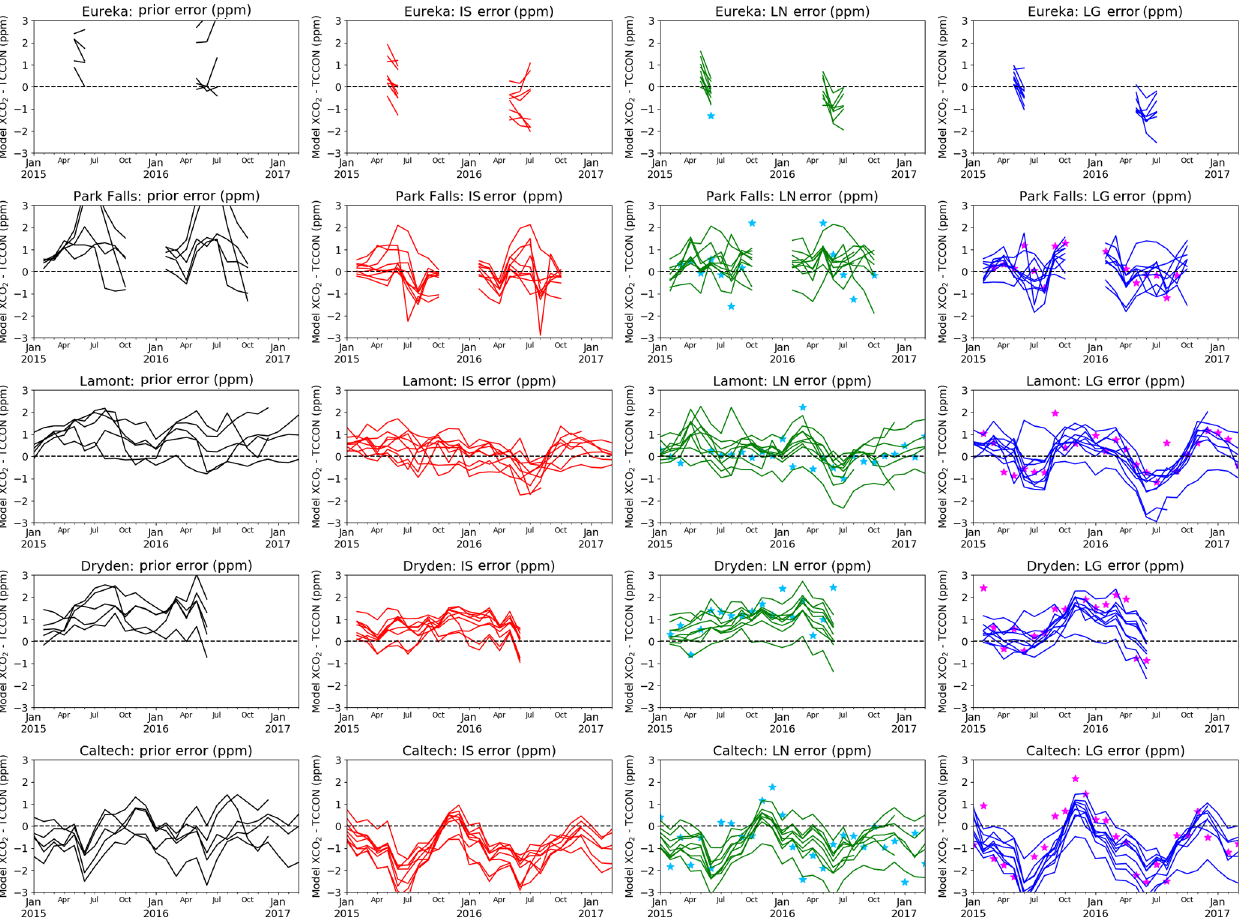
Figure C2. The time series of monthly mean residuals between simulated X CO sites in North America. Each line represents a different model. The sites are arranged from north to south by site latitude. The colors denote the prior concentrations (grey), as well as the posterior concentrations from forward runs using fluxes constrained by in situ (IS, red), land nadir (LN, green), and land glint (LG, blue) data. For the LN and LG residuals, monthly OCO-2 overpass residuals are displayed as stars over the model residuals. Plots are ordered by site